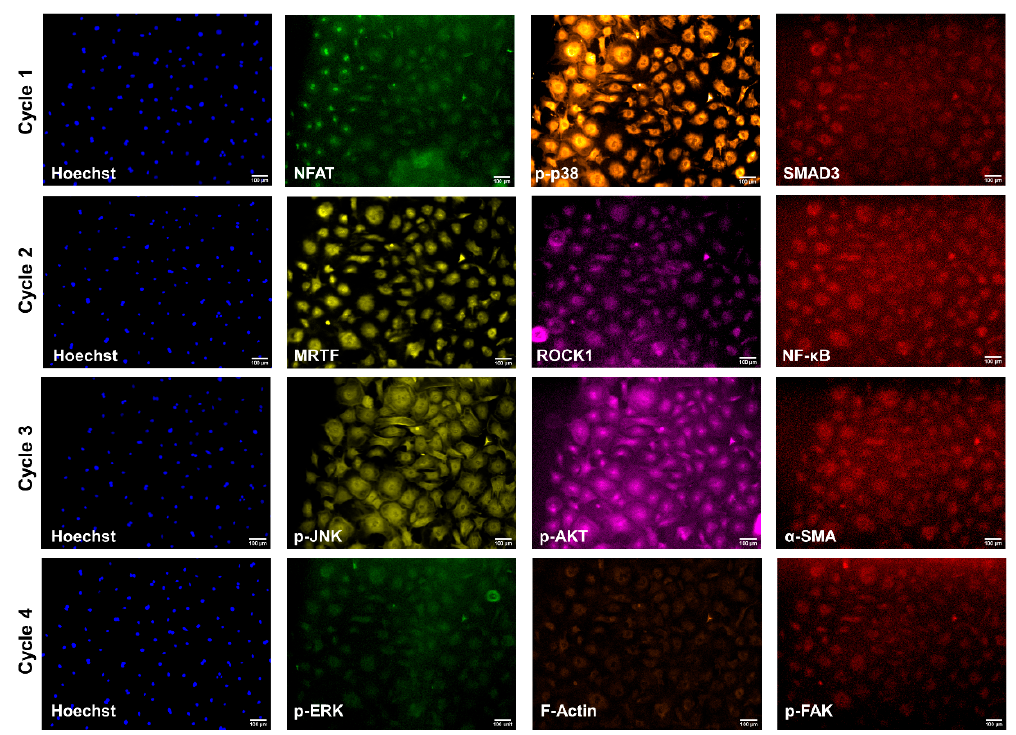
Figure 1. An example of a set of images for each of the proteins of interest for four rounds of CycIF. GFP, TxRed, and Cy7 (green, orange, and red) light cubes were used in rounds 1 and 4. RFP, Cy5, and Cy7 (yellow, pink, and red) light cubes were used in rounds 2 and 3. A Hoechst nuclear stain and DAPI light cube (blue) were used for all rounds.